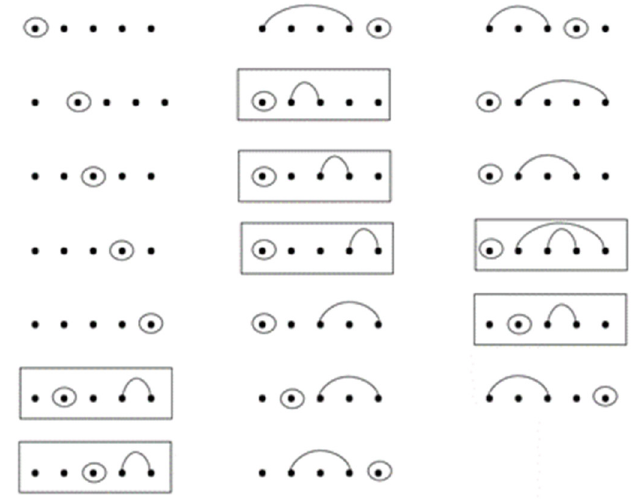
Figure 14. Twenty RNA secondary structures with lengths of five and one base-point mutation, of which seven sequences contain wobble base pairs and thirteen sequences do not contain wobble base pairs.